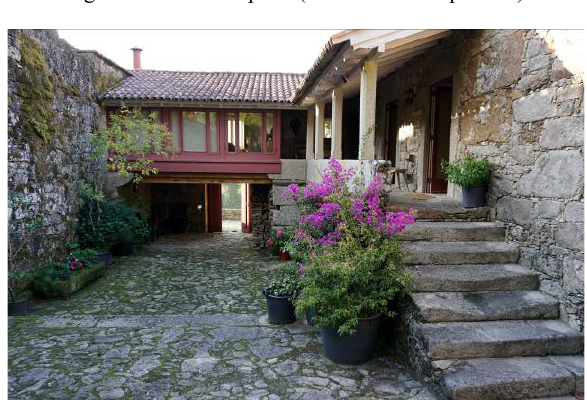
Figure 7. Veranda and glazed porch facing the courtyard.